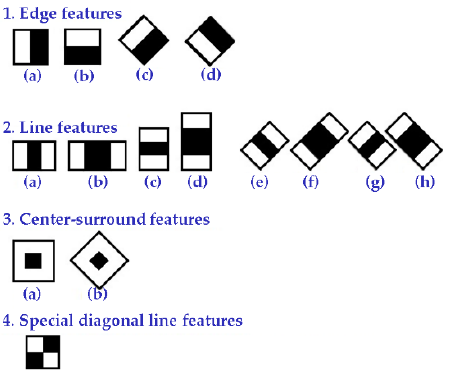
Figure 8. The extended feature sets, wherein, the black and white areas correspond to positive and negative weights, respectively.